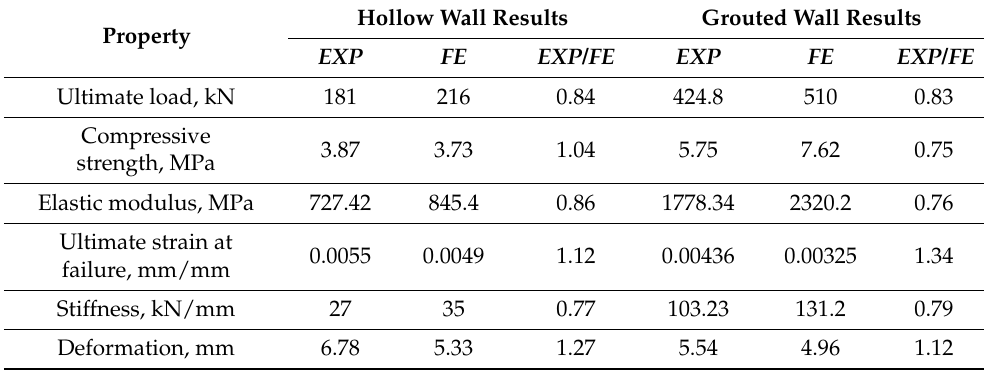
Table 2. Experimental and FE findings for tested masonry walls.